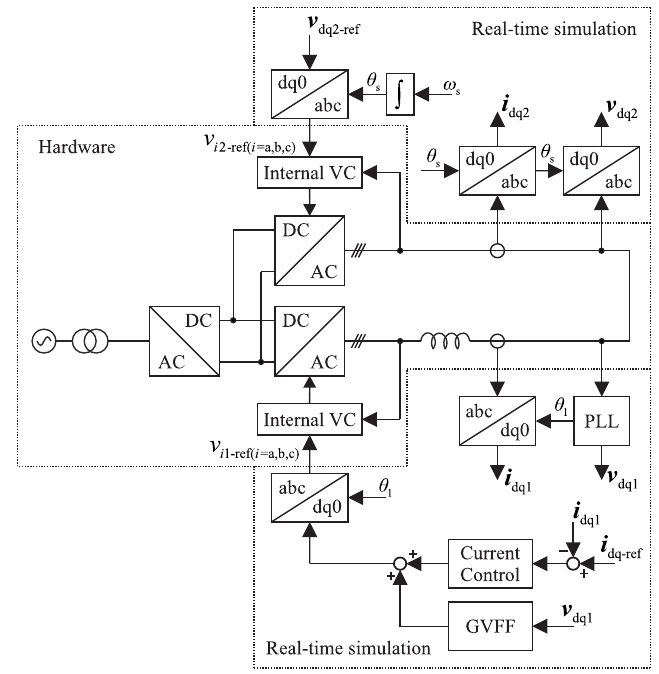
Figure 5. Test setup to verify the emulated